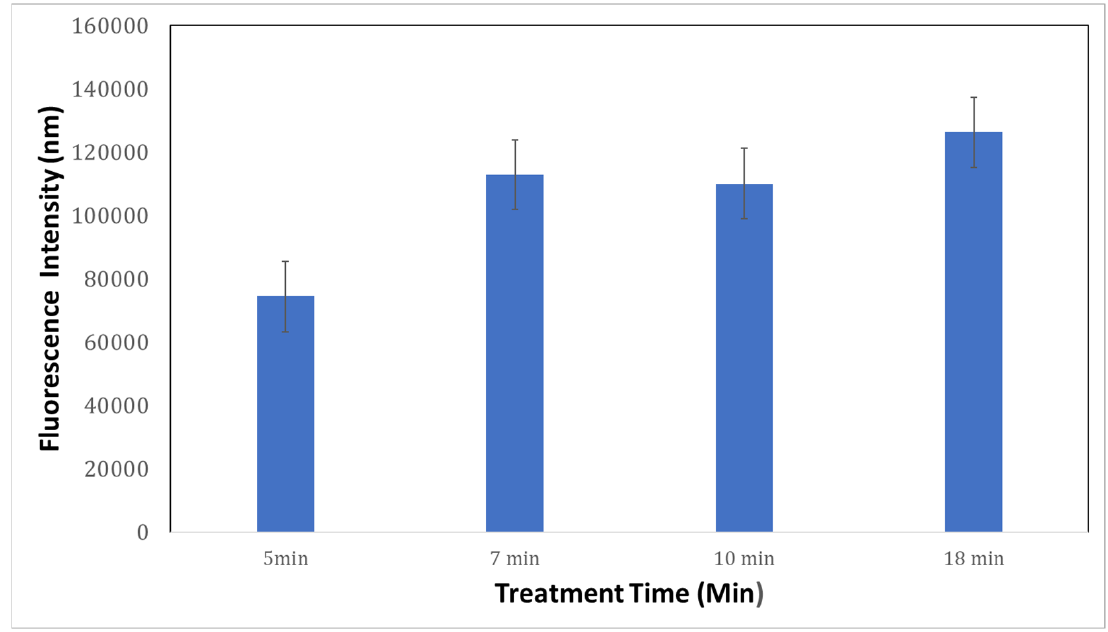
Figure 10. Comparison of average fluorescence intensity between different treatment times.